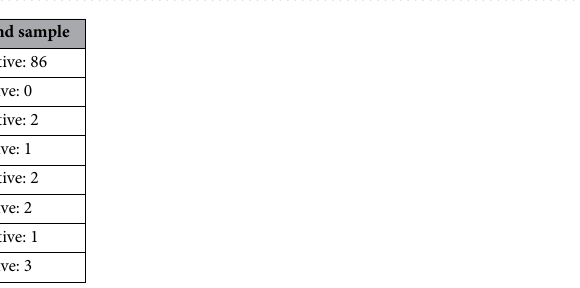
Figure 5. DNA concentration of Methanobrevibacter smithii in healthy and severely malnourished children according to age. Linear regression model representing DNA concentrations (log 10 DNA copies on the Y axis) according to the age of the subject (in months on the X axis). Regression lines are represented separately for each group and its 95% interval confidence range (coefficient of determination r 2 of 0.29 and 0.006 for controls samples and SAM samples respectively) with the green points and line representing healthy children and the red points and line representing severely malnourished children.